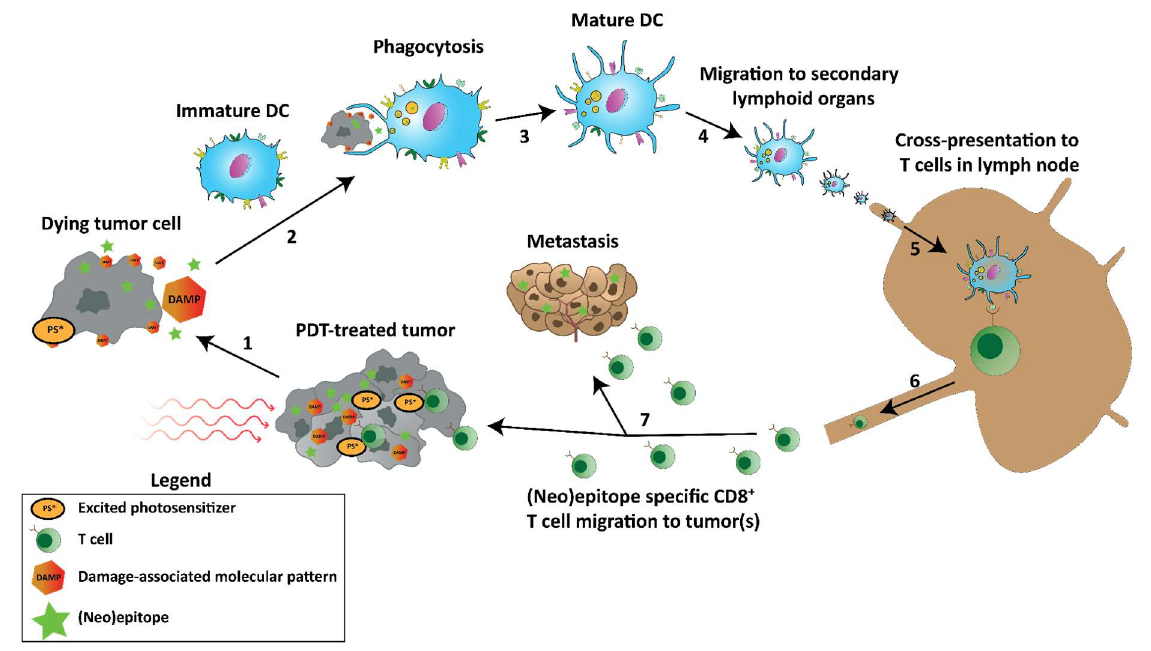
Figure 4. Tumor-specific immune responses induced by PDT. Schematic representation of PDT-induced tumor-specific immune responses. (1) PDT induces cell death in the tumor, releasing DAMPs and previously inaccessible (neo)epitopes. (2) Immature DCs phagocytose the DAMPs, (neo)epitopes, and tumor debris, inducing (3) maturation and (4) migration to secondary lymphoid organs. (5) In those secondary lymphoid organs, such as lymph nodes, the (neo)epitopes are cross-